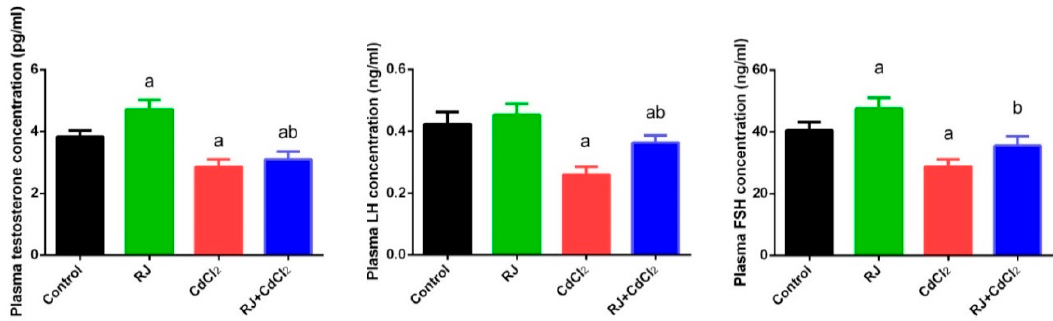
Figure 3. Effects of royal jelly (RJ) on serological testosterone, LH, and FSH levels of mice exposed to cadmium chloride (CdCl 2 ). All values are expressed as mean ± SEM (n = 7). a refers to a significant change from the control mice at p < 0.05; b refers to a significant change from the CdCl 2 -treated mice at